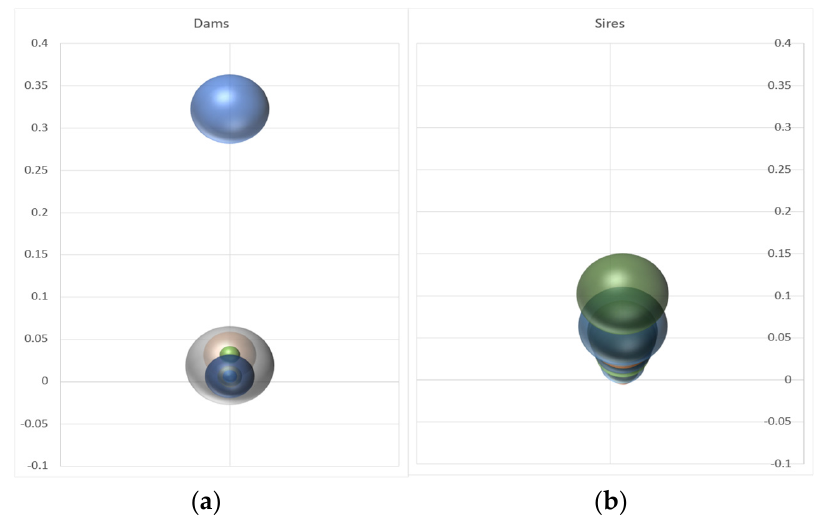
Figure 4. Bubble graphs showing the mean genetic contributions of single dams ( a ) and sires ( b ) across different breeding units. The Y-axis denotes the proportion of offspring per dam and sire. Table 1. Predicted rates of inbreeding and effective population size ( Ne ) for different production batches. DF 1 (Predicted rate of inbreeding: Wooliams and Thompson, 1991); Ne 1 ( Ne : Wooliams and Thompson, 1991); DF 2 , (Predicted rate of inbreeding: Waples and Waples, 2005); Ne 2 (Waples and Waples, 2005); ONF (Observed number of females); ON M (Observed number of males); N F (Number of contributing females); N M (Number of contributing males); ENF, (Effective number of founders); E kf (Average family size of females); E km (Average family size of males); V kf (Variance of family size of females); V km (Variance of family size of males). R3 ′ corresponds to a different production batch from the breeding unit R3. Breeding Unit